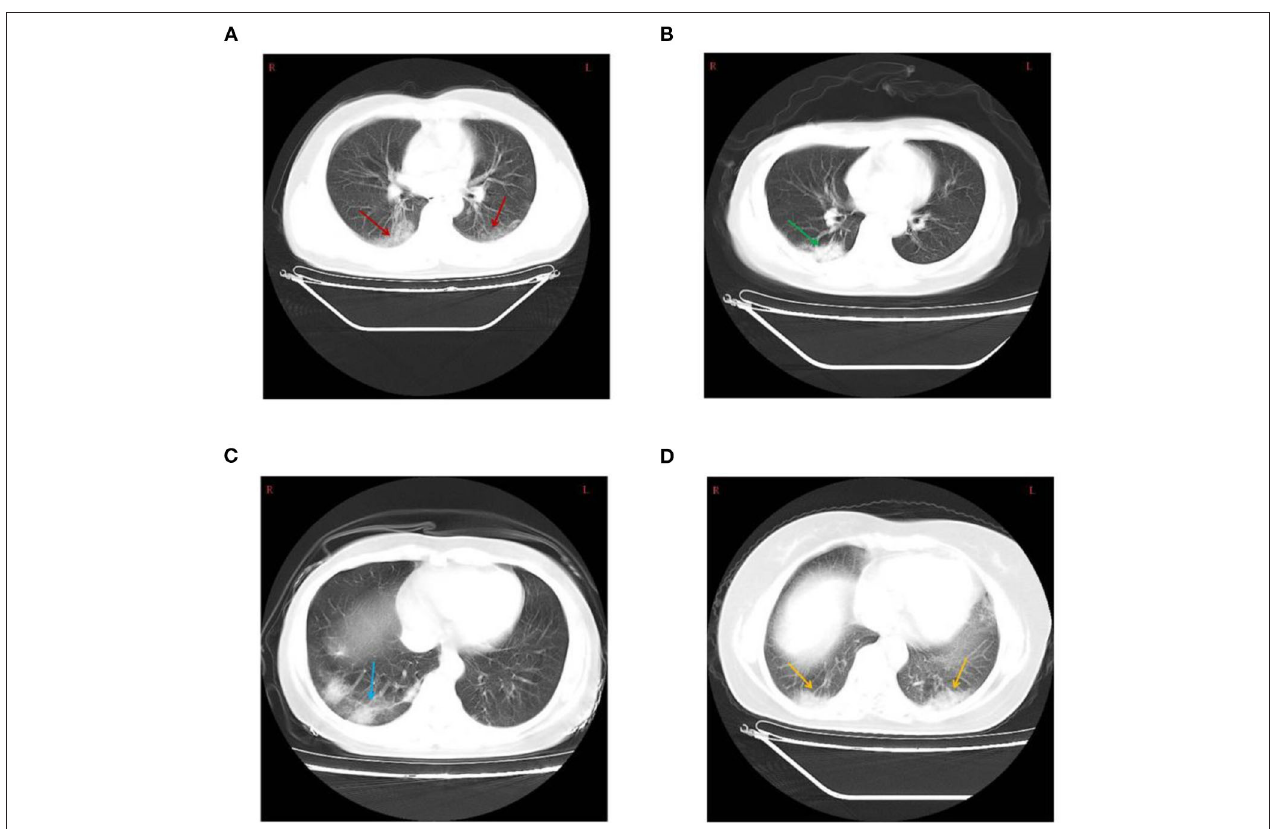
FIGURE 1 | (A) Chest computed tomography showing bilateral diffuse ground-glass opacity (red arrow) in a 43-year-old male patient. (B) Patchy shadow of the right lung (green arrow) in a 44-year-old female patient. (C) Consolidation and Strip-shaped shadows of the right lung (blue arrow) in a 43-year-old female patient. (D) Bilateral lung patchy shadow (yellow arrow) in a 42-year-old female